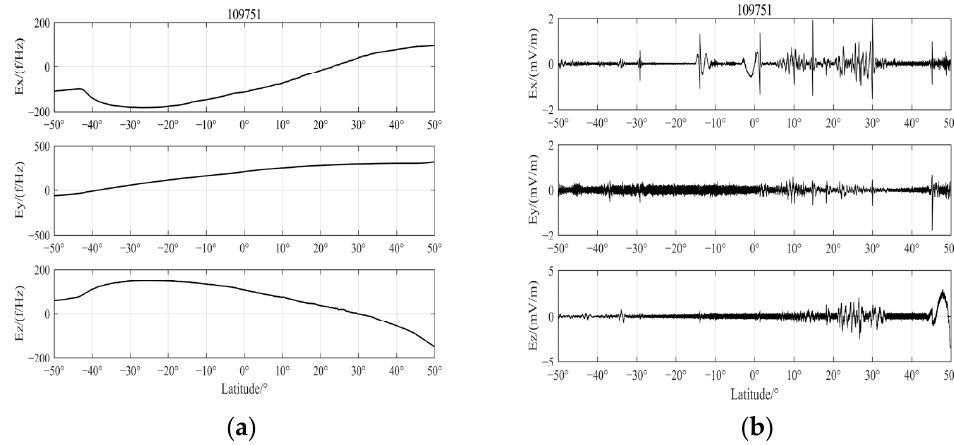
Figure 5. Original signal and reconstructed signal of 109,751 track. ( a ) Original signal; ( b ) recon- structed signal.